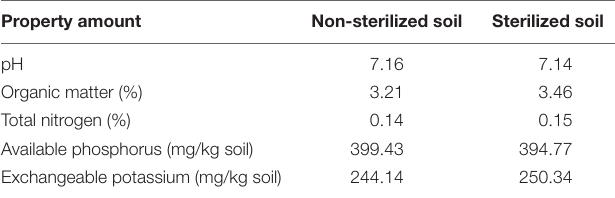
TABLE 2 | Soil properties used in the pot